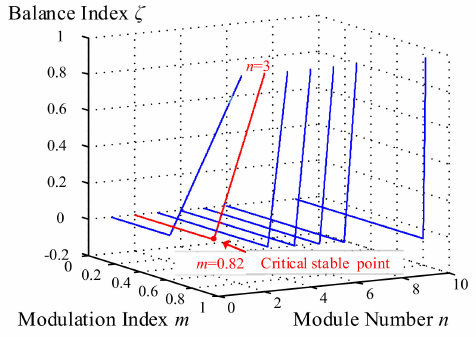
Figure 5. Balance boundary of